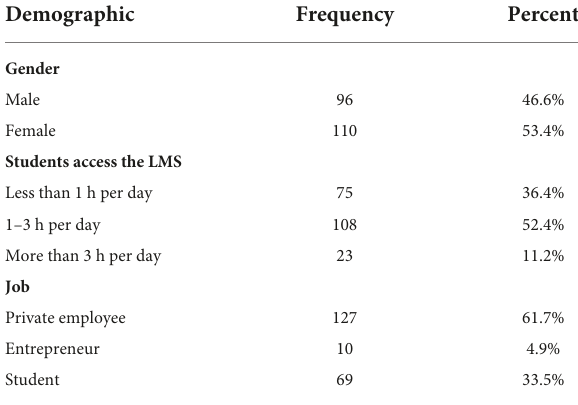
TABLE 1 Demographic of participants ( n =